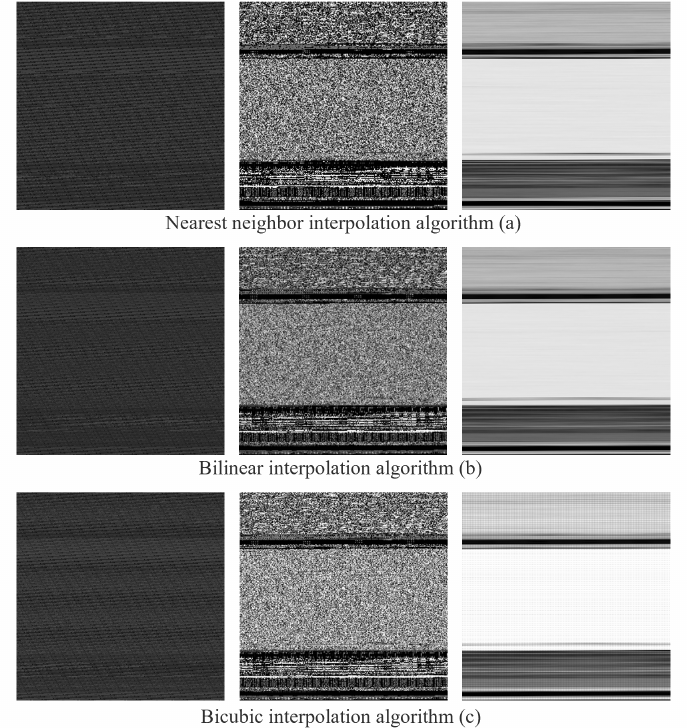
Figure 3. Grayscale images processed by different interpolation